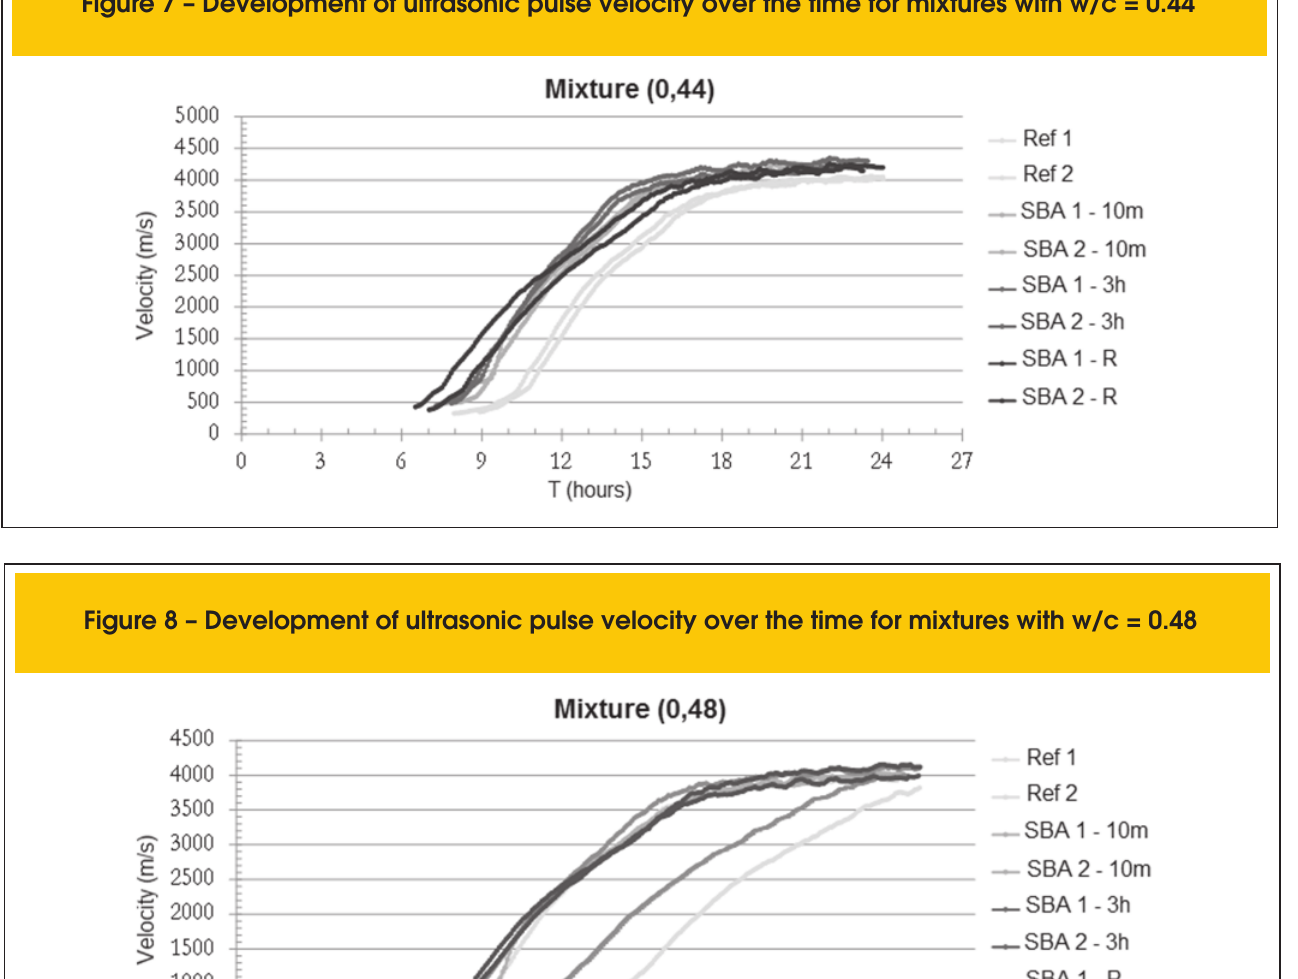
Figure 7 – Development of ultrasonic pulse velocity over the time for mixtures with w/c = 0.44